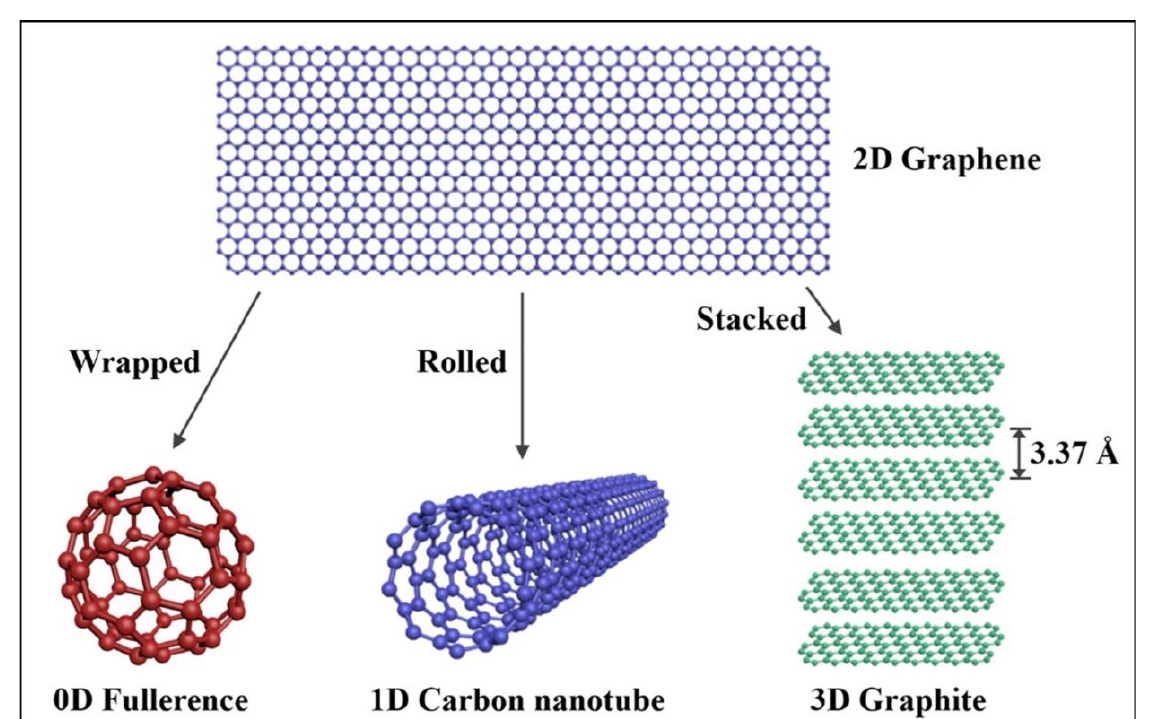
Figure 1. Allotropic forms of carbon structures. Reprinted with permission from Ref. [2].